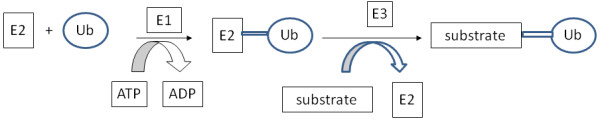
The ubiquitination cascade. E1 denotes ubiquitin-activating enzyme, E2: ubiquitin conjygating enzyme and E3 ubiquitin ligase. Ub: ubiquitin.